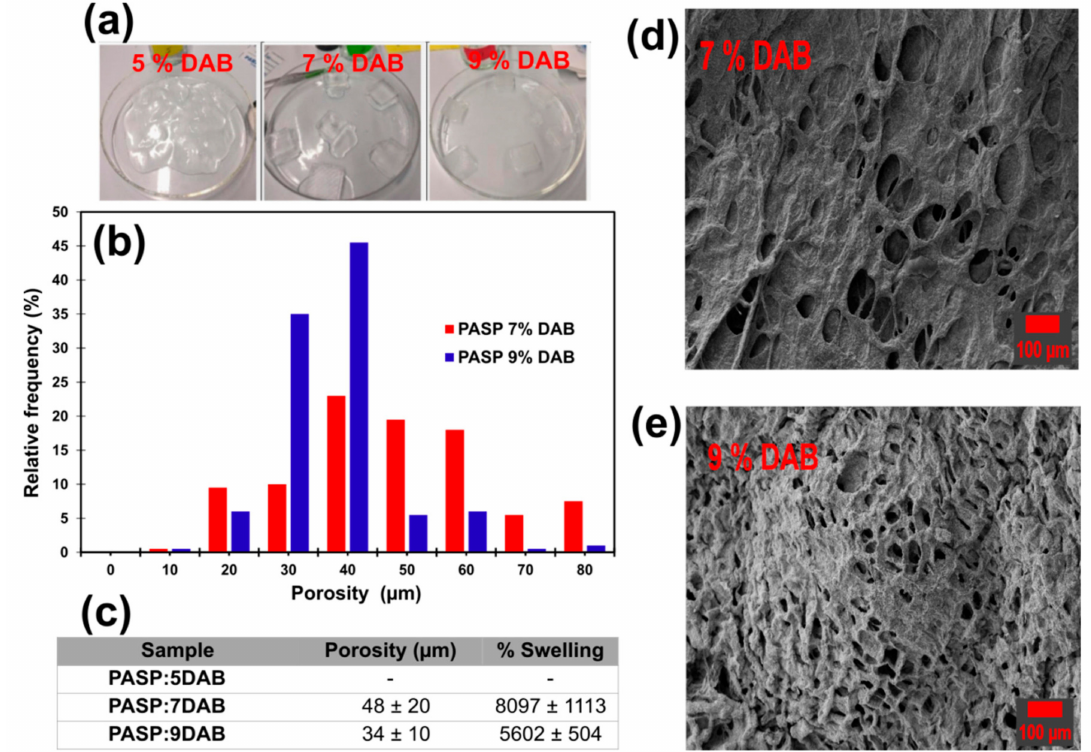
Figure 3. ( a ) Structural stability of cross-linked and swelled PASP hydrogels. ( b ) Pore size distribution histogram of PASP hydrogel synthesized by using different DAB percentages. ( c ) Overview of the porosity and swelling values for the different PASP hydrogels (standard deviation are also shown). Surface SEM images of ( d ) PASP:7DAB and ( e ) PASP:9DAB hydrogels. Micrographs recorded with 100 × magnifications are